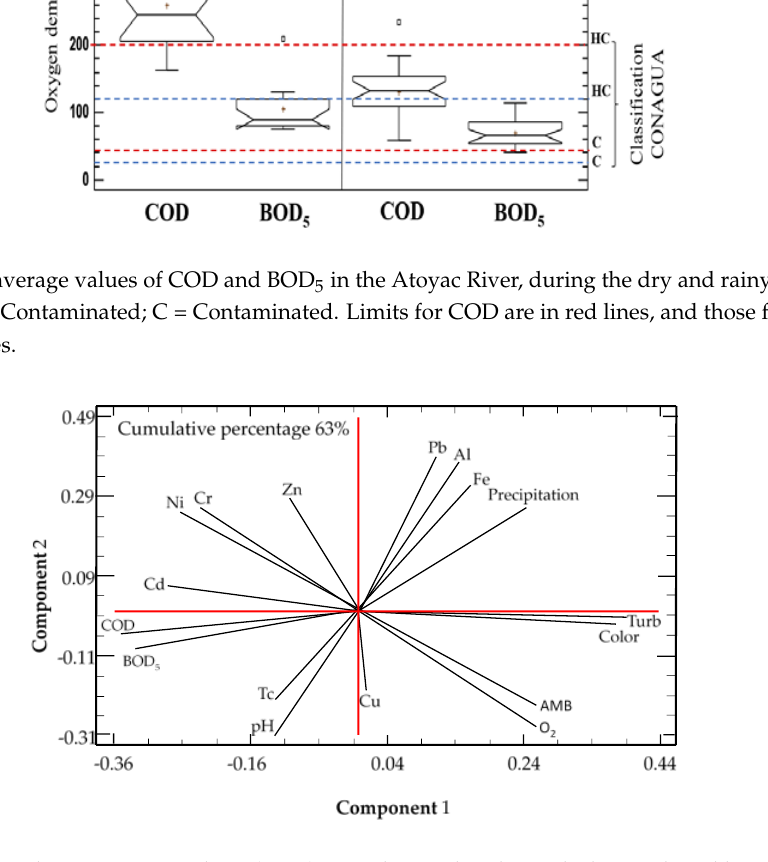
Figure 3. Principal component analysis (PCA) considering the physical, chemical, and bacteriologic variables of the Atoyac River and level of the precipitation in 2016.